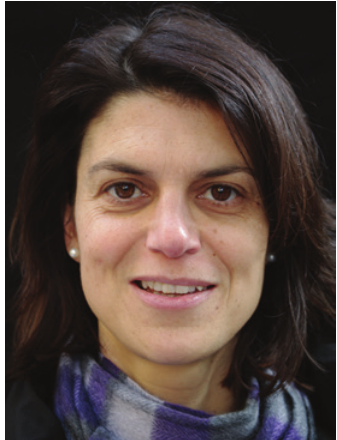
Figure 10 Theano Moussouri (Source: photograph by Theano